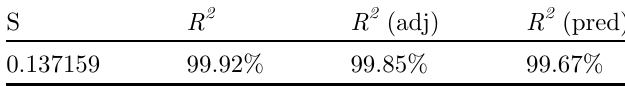
Table 9. Model summary.